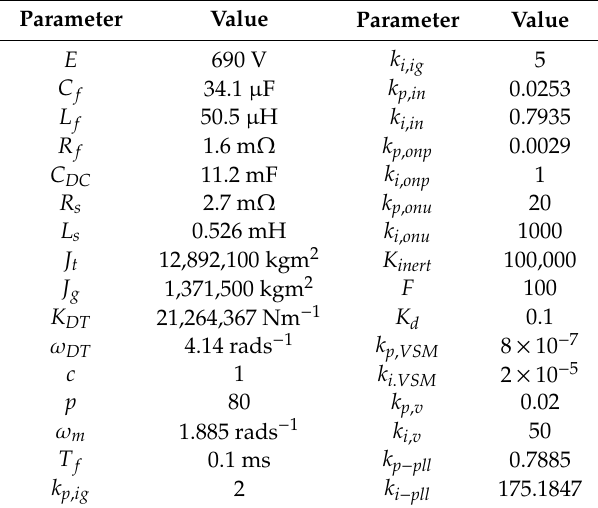
Table 1. Parameter values.